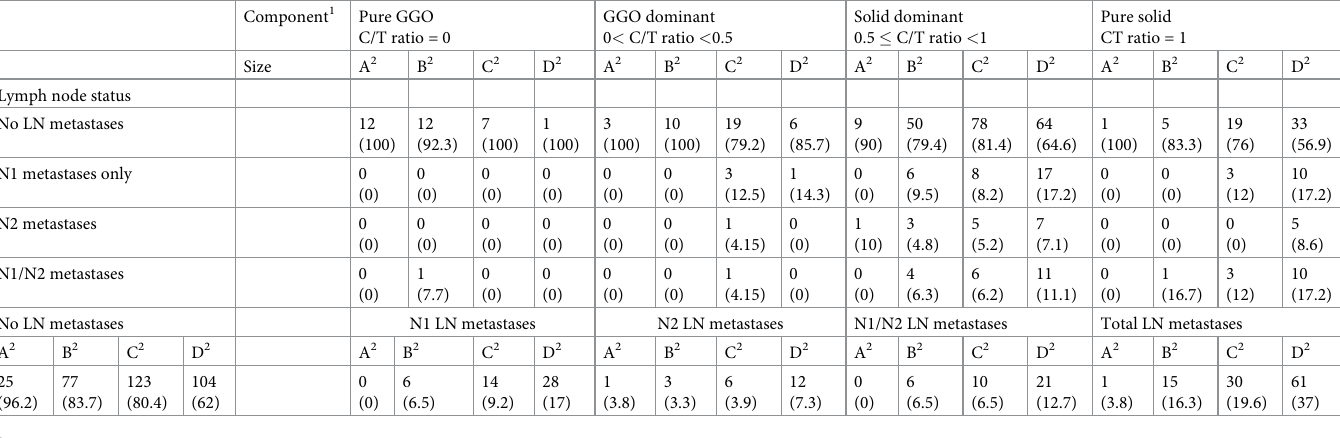
Table 3. Tumor component vs. lymph node metastatic pattern in different tumor